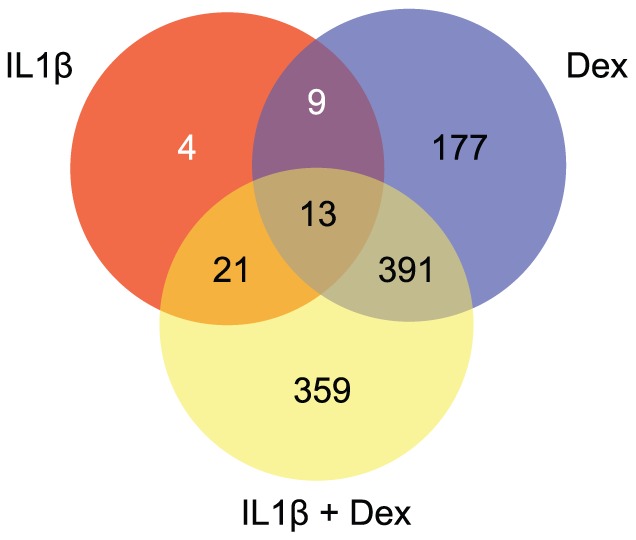
Number and overlap of genes differentially expressed due to IL1β, DEX, and IL1β+DEX treatment.Cells were treated with 10/ml IL1β or vehicle and harvested 18 h later. Total RNA was extracted and gene expression profiling was performed on Illumina HT-12 v4.0 BeadChips. The venn diagram shows the overlap of genes differentially expressed by the different treatments relative to control treated cells.